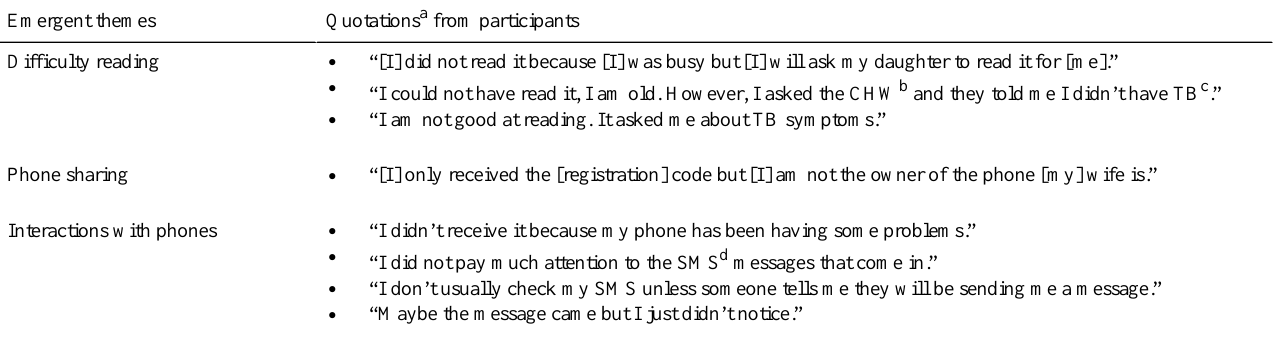
Table 2. Quotations from participants on their experiences with short message service text messages. Quotations a from participantsEmergent